Question: Write a single sentence explaining what this figure depicts.
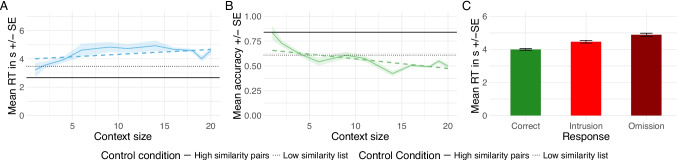
Answer: Results Experiment 3. A The effect of semantic context on RTs. The two black lines show the mean RTs of the two control conditions. B The effect of semantic context on accuracy. The two black lines show the mean accuracy of the two control conditions. C The mean RT for the different response types. All shaded areas around the mean and the error bars represent the standard error (SE) of the mean